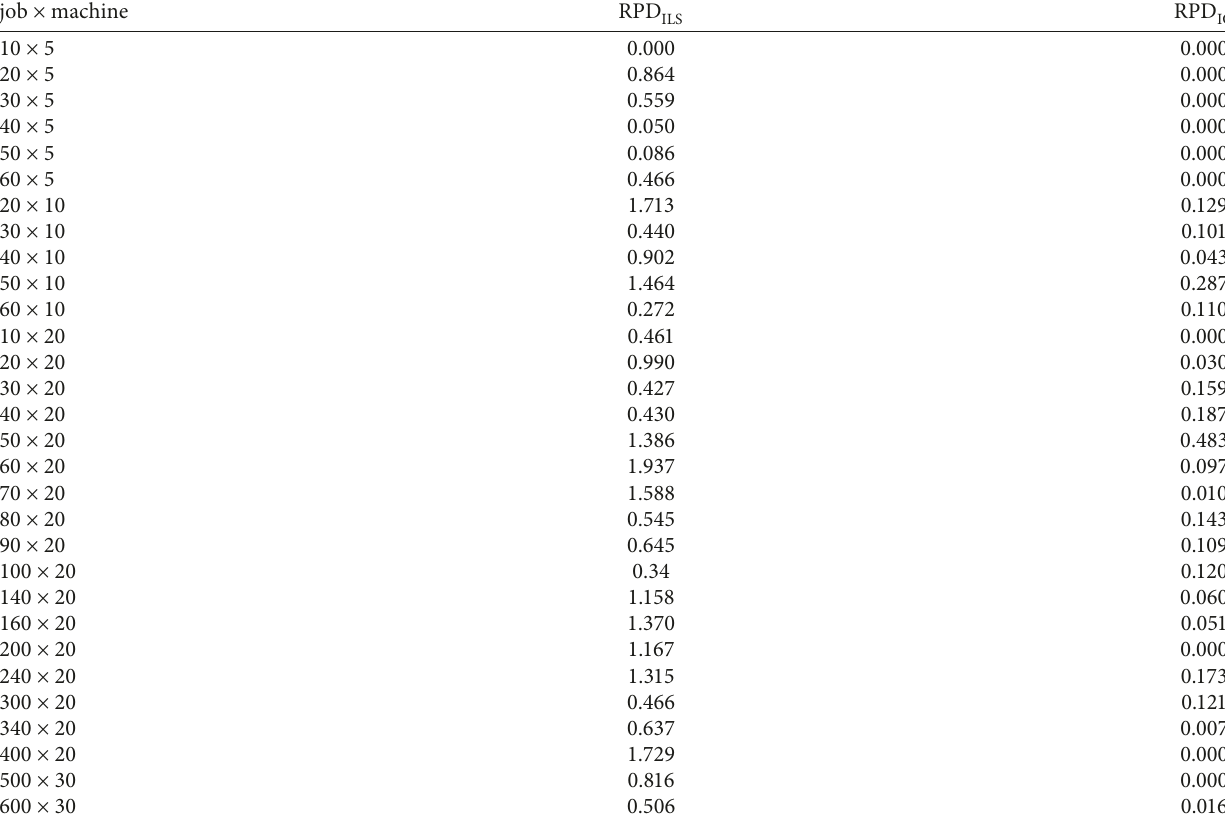
Table 3: Comparison between iterated local search and iterated greedy.